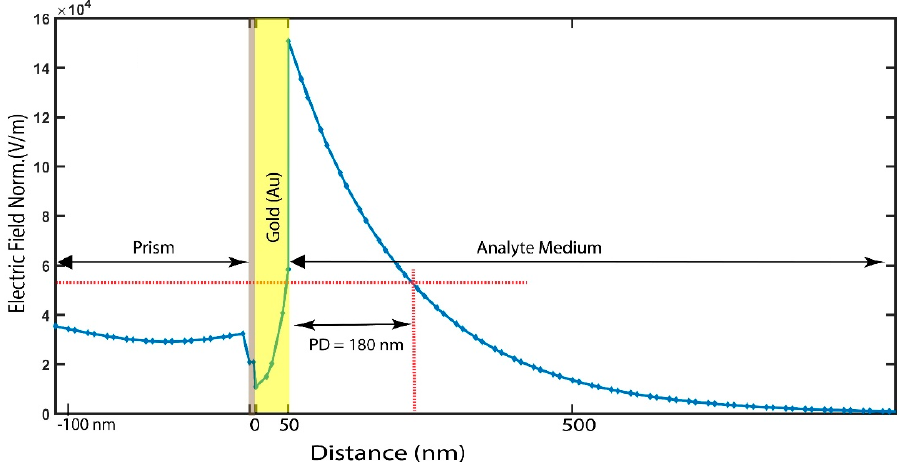
Figure 5. Cross-section plot of the total electric field along the direction perpendicular to the prism base at an analyte refractive index of 1.36 and a resonance angle of 75.6, showing a clear evanescent field at the sensing interface.